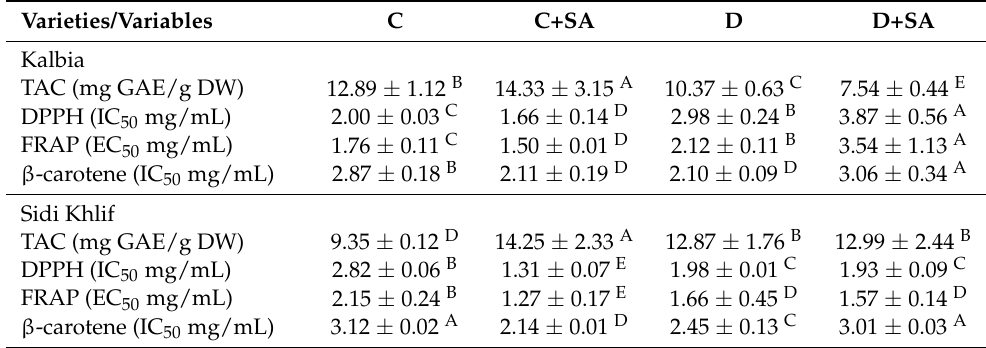
Table 6. Antioxidant activities of Sulla carnosa cv. Kalbia (KA) and Sidi Khlif and (SK), primed with salicylic acid (SA) and grown under different Fe concentrations for 8